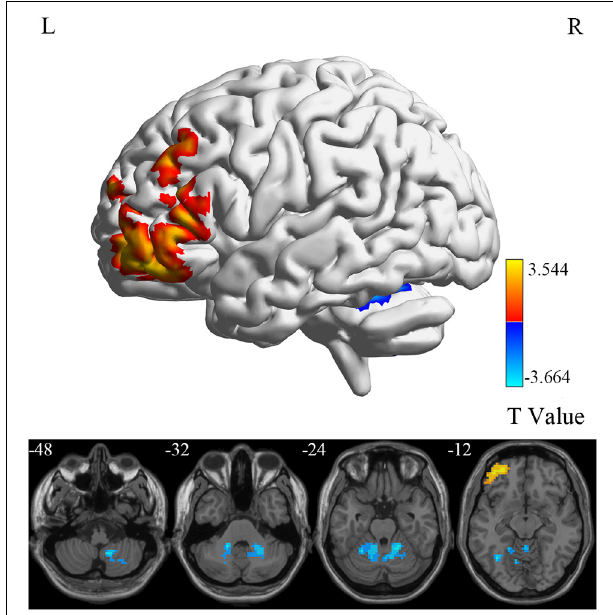
FIGURE 2 | ALFF differences between MCI reverters and HCs. ALFF, amplitude of low-frequency fluctuation; HCs, healthy controls; L, left; MCI, mild cognitive impairment; R, right.